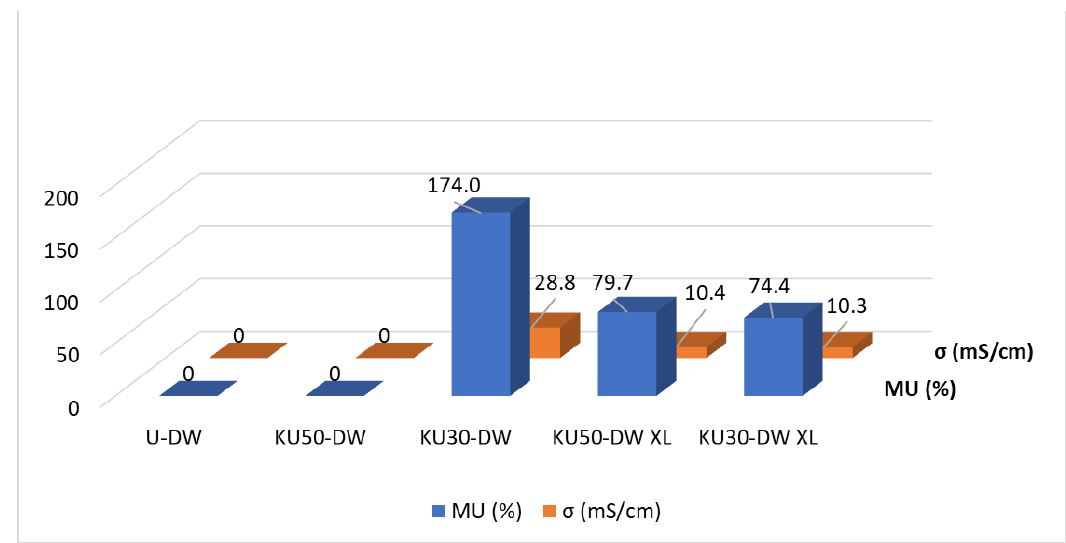
Figure 5. Comparison of SPEEK/SPPSU blend membranes cast from 10% DMSO and 90% water and crosslinked.